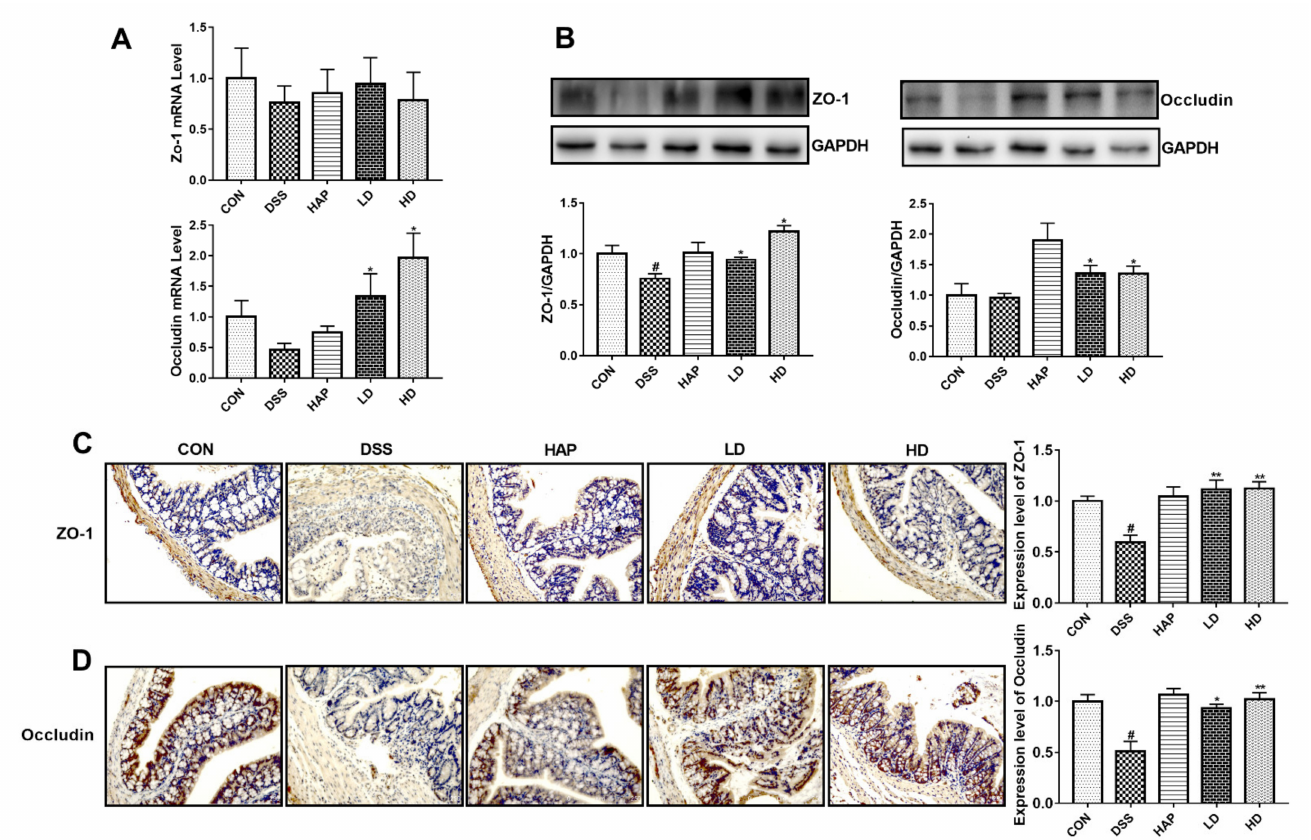
Figure 4. Effect of APE on intestinal tight junction proteins: ( A ) The mRNA levels of zonula occludens-1 ( Zo-1 ) and Occludin in colon tissue were determined by RT-PCR. ( B ) The protein levels of ZO-1 and Occludin in colon tissue were measured by Western blot. The protein levels of ZO-1 ( C ) and Occludin ( D ) were determined by immunohistochemistry. n = 8 or 9. # p < 0.05 vs. CON group. * p < 0.05 vs. DSS group. ** p < 0.01 vs. DSS